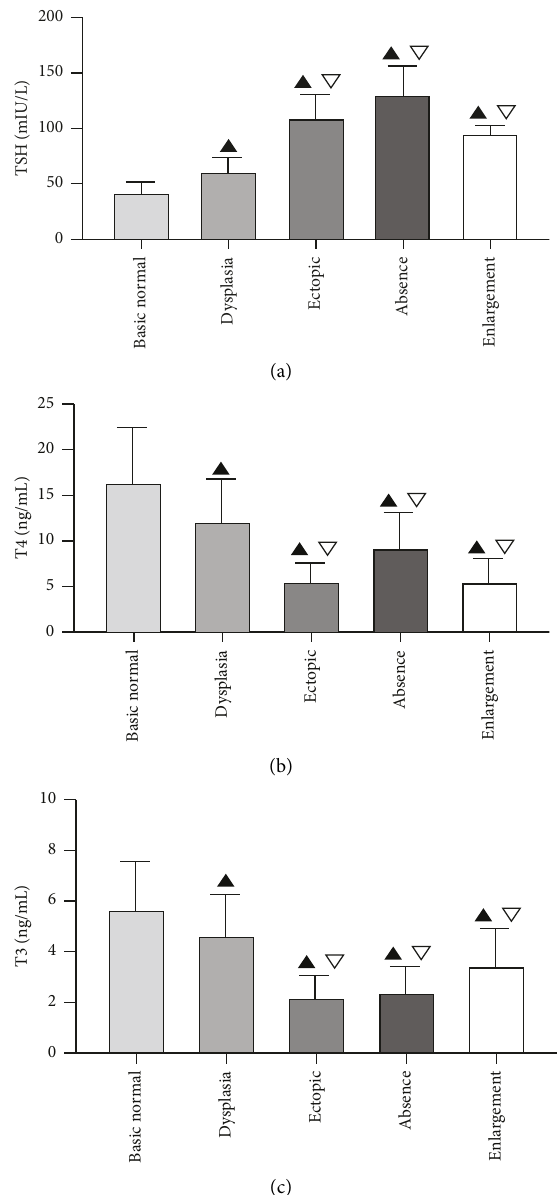
Figure 1: Serological characteristics of children with CH with different thyroid changes (mean; SD). Note: (a) TSH levels, (b) T4 levels, and (c) T3 levels. Compared with the basic normal thyroid gland, ▲ P < 0 . 05. Compared with thyroid dysplasia, ▽ P < 0 .